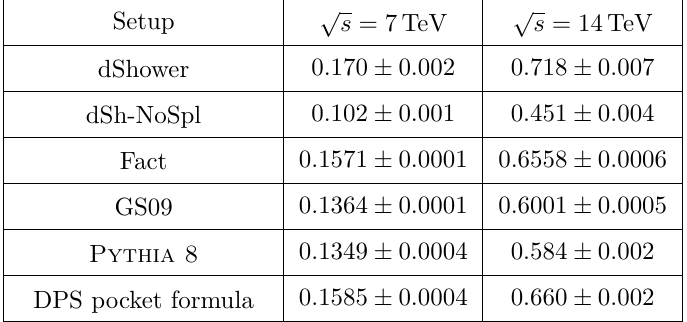
Table 1 . Total DPS cross section in femtobarns [fb] for di(cid:11)erent setups and for di(cid:11)erent centre-of- mass energies p s . The statistical error is